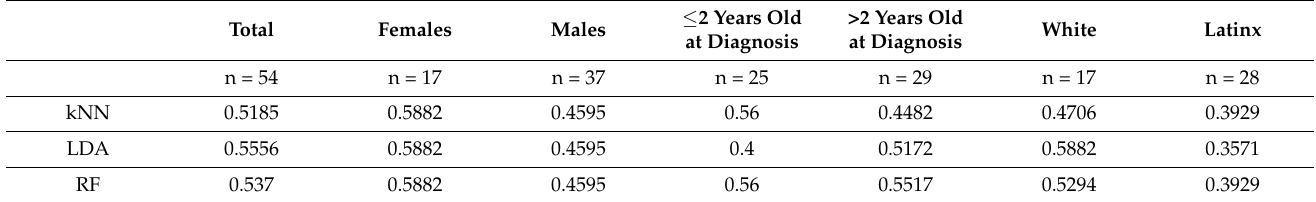
Figure 1. Boxplots of log abundances for each folate pathway metabolite, stratified by case/control status, following filtering and normalization. Blue = cases (n = 92) and red = controls (n = 92). Note the different y-axis scales. Table 2. Classification error rates for each candidate class predictor after being trained on the learning set and then evaluated on the hold-out test